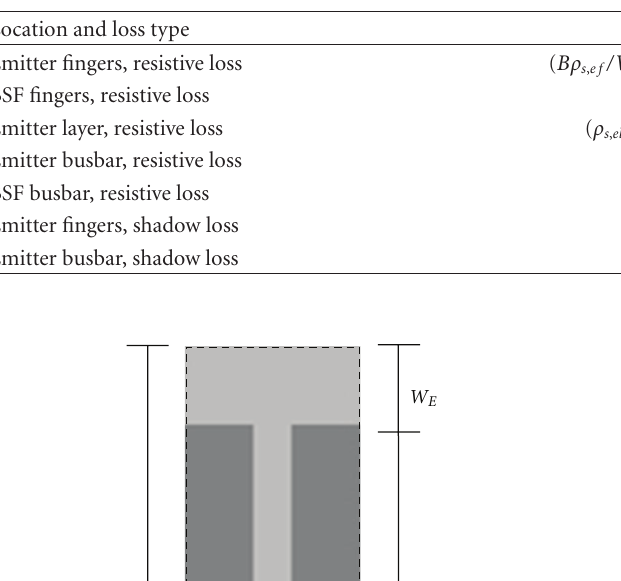
Table 1: Location, loss type, quantified power loss, and unit cell area for the various power loss mechanisms present in interdigitated metallization for poly-Si thin-film solar cells.